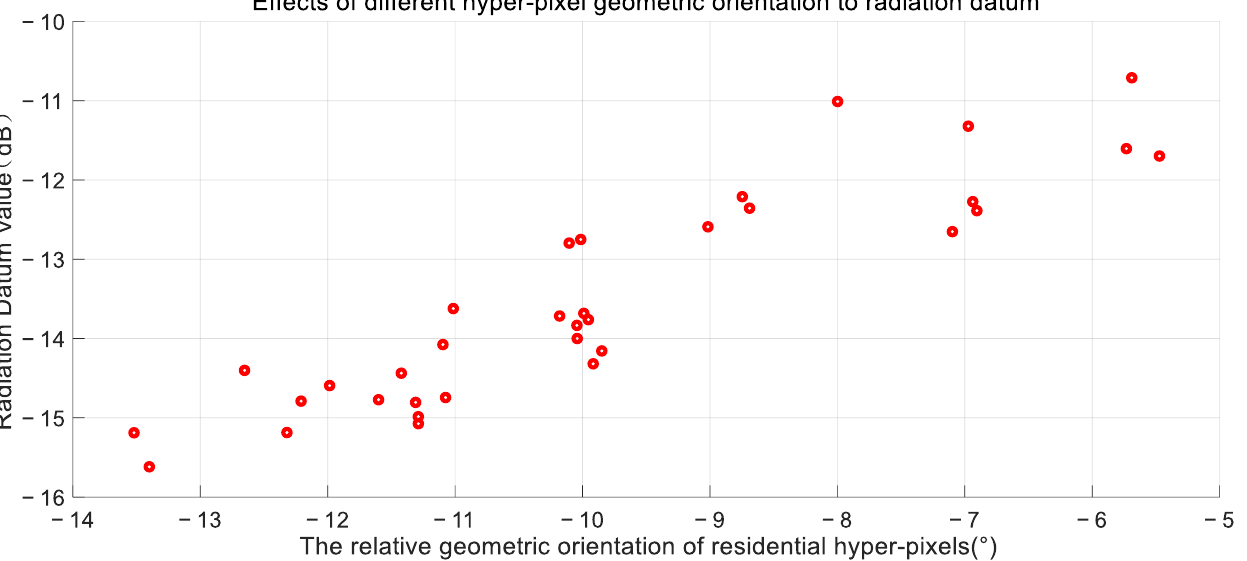
Figure 13. Results of GF-3 experiments in the same residential area in San Diego: Effects of hyper-pixels’ relative geometric orientations on radiation datum.